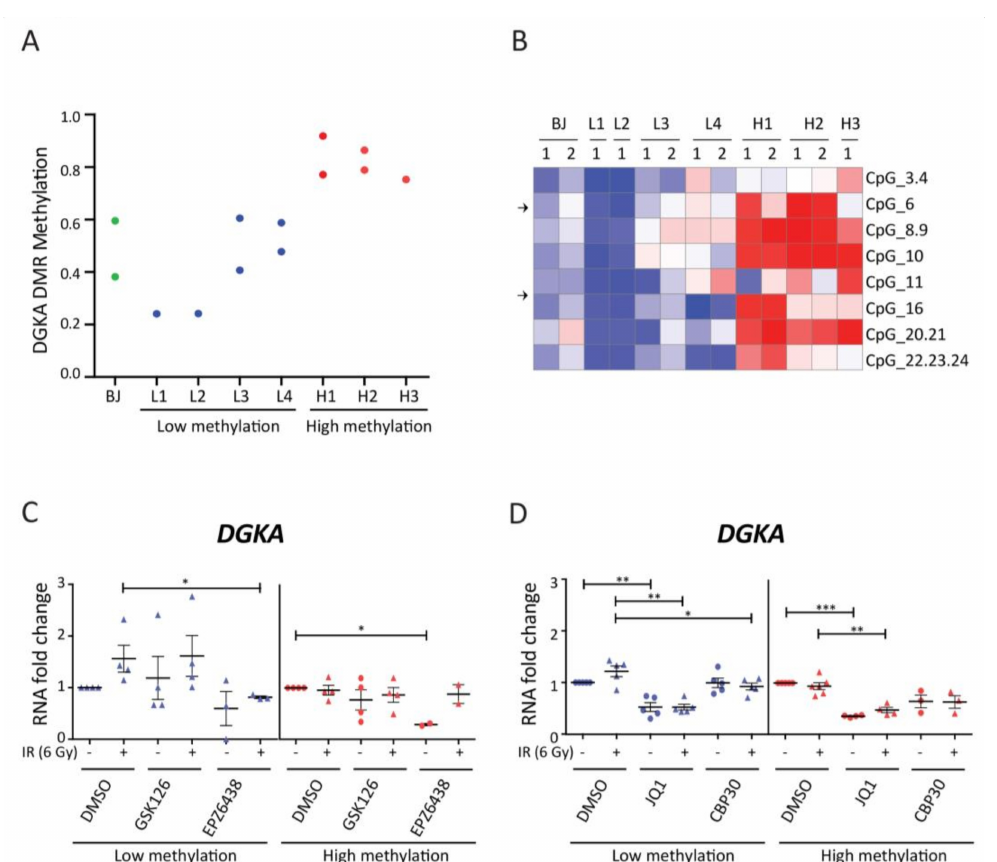
Figure 6. Effects of epigenetic inhibitors in human dermal fibroblasts with low or high DNA methylation at the DGKA enhancer: ( A ) Methylation average across informative CpGs located in the DGKA enhancer in BJ and normal human dermal fibroblasts (NHDFs, L1-4 and H1-3). Methylation was measured as β -values by EpiTYPER technology. ( B ) Heatmap for DNA methylation of all CpG sites measured in BJ and NHDFs. For each cell type, one or two replicates (1,2) are shown. Arrows indicate the location of the EGR1-binding motifs. The first EGR1-binding site (EGR1_1) covers CpG_6, and the second binding site (EGR1_2) covers CpG_14, which is located between CpG_11 and CpG_16 and not detected by EpiTYPER. For ( A , B ), data are depicted from one or two experiment in each single NHDF. (C-D) Cells were pre-treated with EZH2 inhibitors (5 µ M GSK126 or 50 µ M GSK126) ( C ) or bromodomain inhibitors (10 µ M CBP30 or 5 µ M JQ1) ( D ), irradiated with 6 Gy, and incubated for another 48 h with concurrent drug treatment before harvest. Data points summarize effects for both fibroblast groups and include at least duplicate experiments. Statistical data are presented as mean ± SEM, and statistical significance (* p < 0.05, ** p < 0.01, and *** p < 0.001) was determined by one-tailed Student’s t